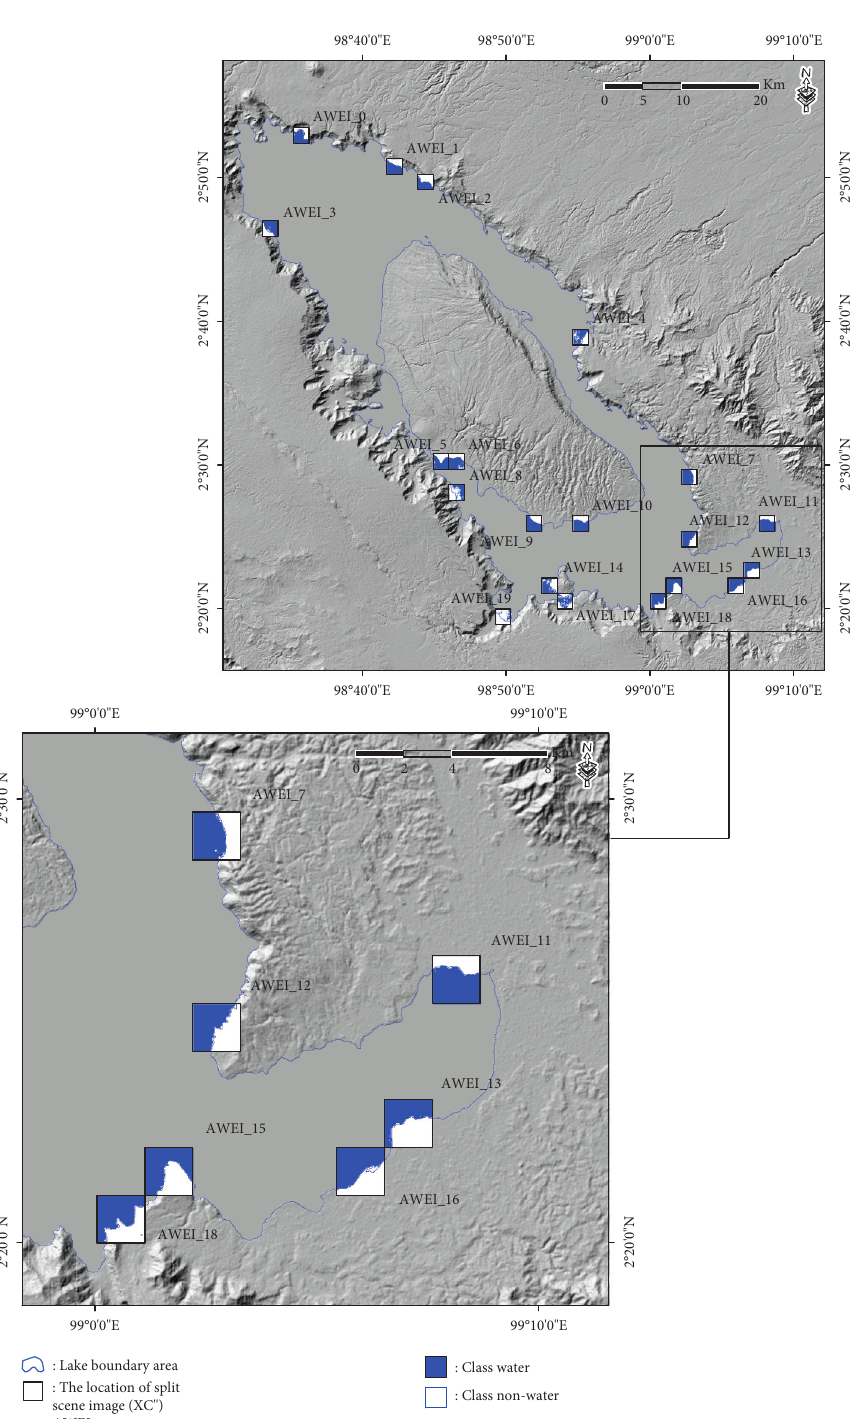
Figure 8: Location of the split scene image selection in the scene data ( XC ″ ) of the subscene images ( XCi ″ ) with a size of 2km × 2km based on the geometrical interval threshold